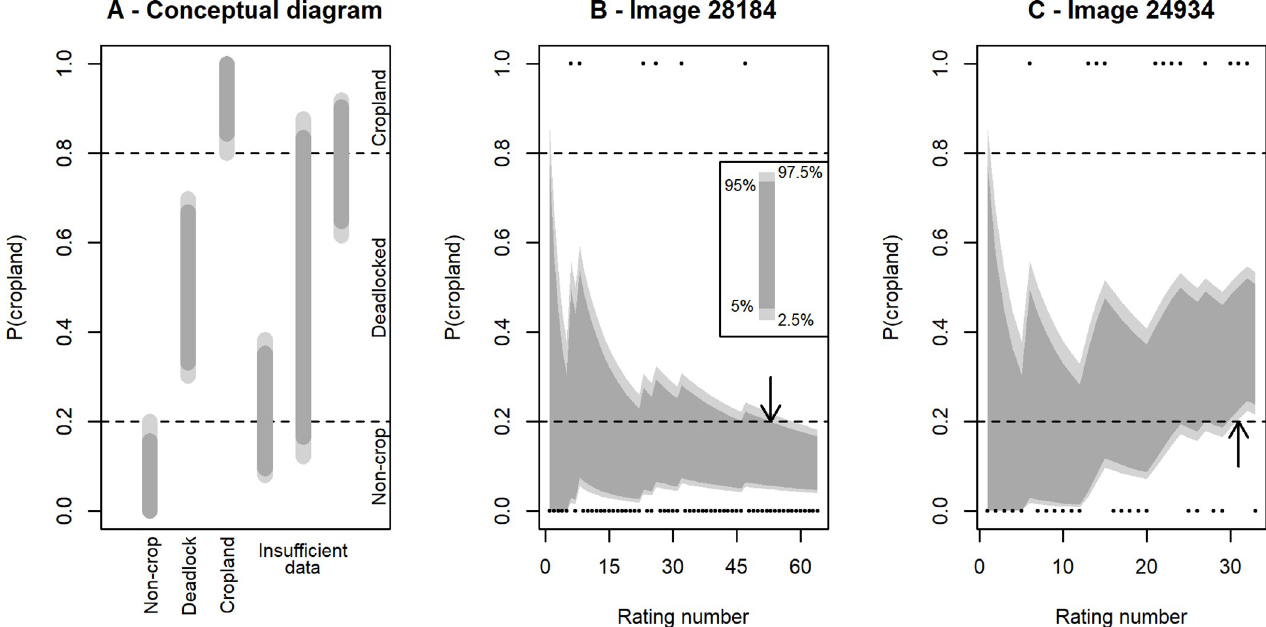
Fig 1. A graphical illustration of our proposed method to efficiently decide that an image is sufficiently well classified. When one of the conditions illustrated here are met, the task can be pulled from circulation as a volunteer classification task. Panel (A) demonstrates the decision-making mechanism. The inset in panel B shows how the different shading intensities indicate different quantile levels; the two shades of gray have identical meanings in all three panels. If the 95th percentile of the posterior distribution is below the selected disagreement rate (20% in our case—horizontal dashed lines), then the image is concluded to contain no cropland. Similarly, if the 5th percentile is above 80% cropland, then we conclude that it does contain cropland. Note that in both of these cases, it is fine if the wider (light gray) interval still overlaps the target disagreement rate. If the central 95% (i.e. 2.5% to 97.5%) of the posterior distribution is entirely between 20% and 80%, the image is pulled from circulation because the crowd is unlikely ever to reach a definitive conclusion. The right three bars show situations where more data is sought. Panels (B) and (C) depict two applications of this method to real data. The dots along the top and bottom of the panels show actual ratings data. The dark and light gray shaded areas (representing the same ranges as in panel A) show how the estimated probability of cropland vs. non-cropland classifications changes with additional classifications. The arrows show the point at which the decision is made to withdraw an image from circulation. Note that in panel B this decision is made when the 95th percentile (i.e. dark gray region) falls below the target, but that in panel C, the conclusion is only reached when the light gray regions are entirely between the targets.